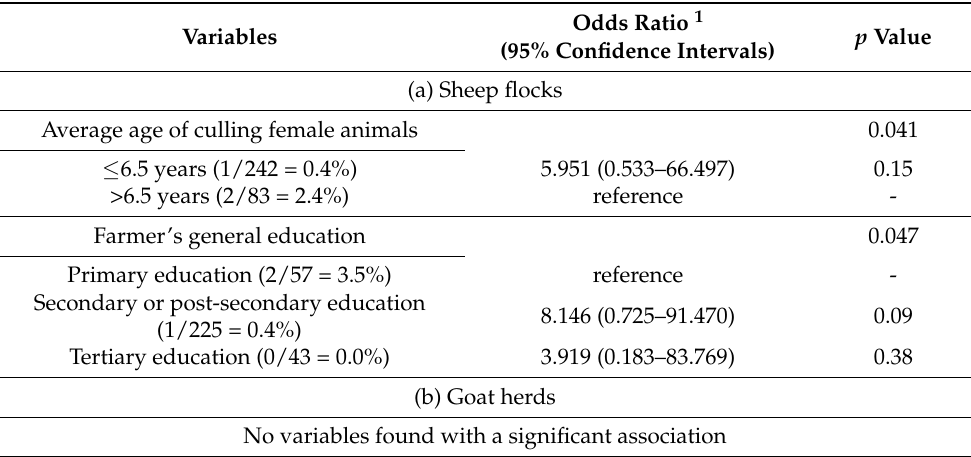
Table A4. Multivariable analysis for variables associated with optional vaccination against contagious ecthyma in 444 small ruminant farms in Greece.